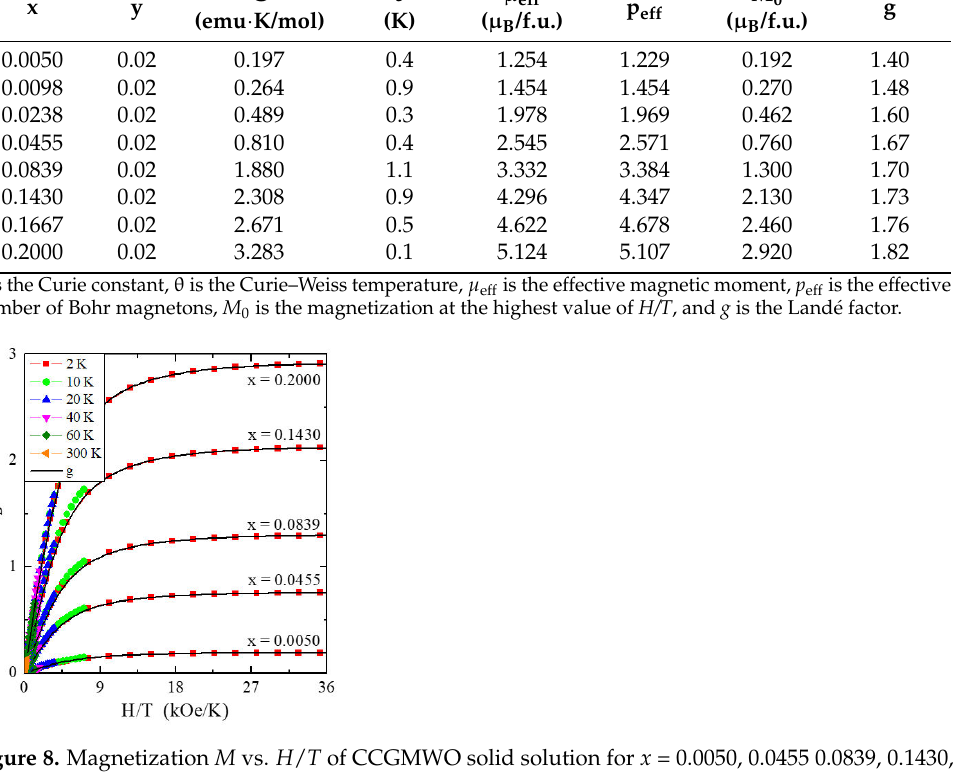
Figure 8. Magnetization M vs. H / T of CCGMWO solid solution for x = 0.0050, 0.0455 0.0839, 0.1430, 0.2000, and y = 0.02 recorded at 2, 10, 20, 40, 60, and 300 K. The solid (black) line indicates a Land é factor fit